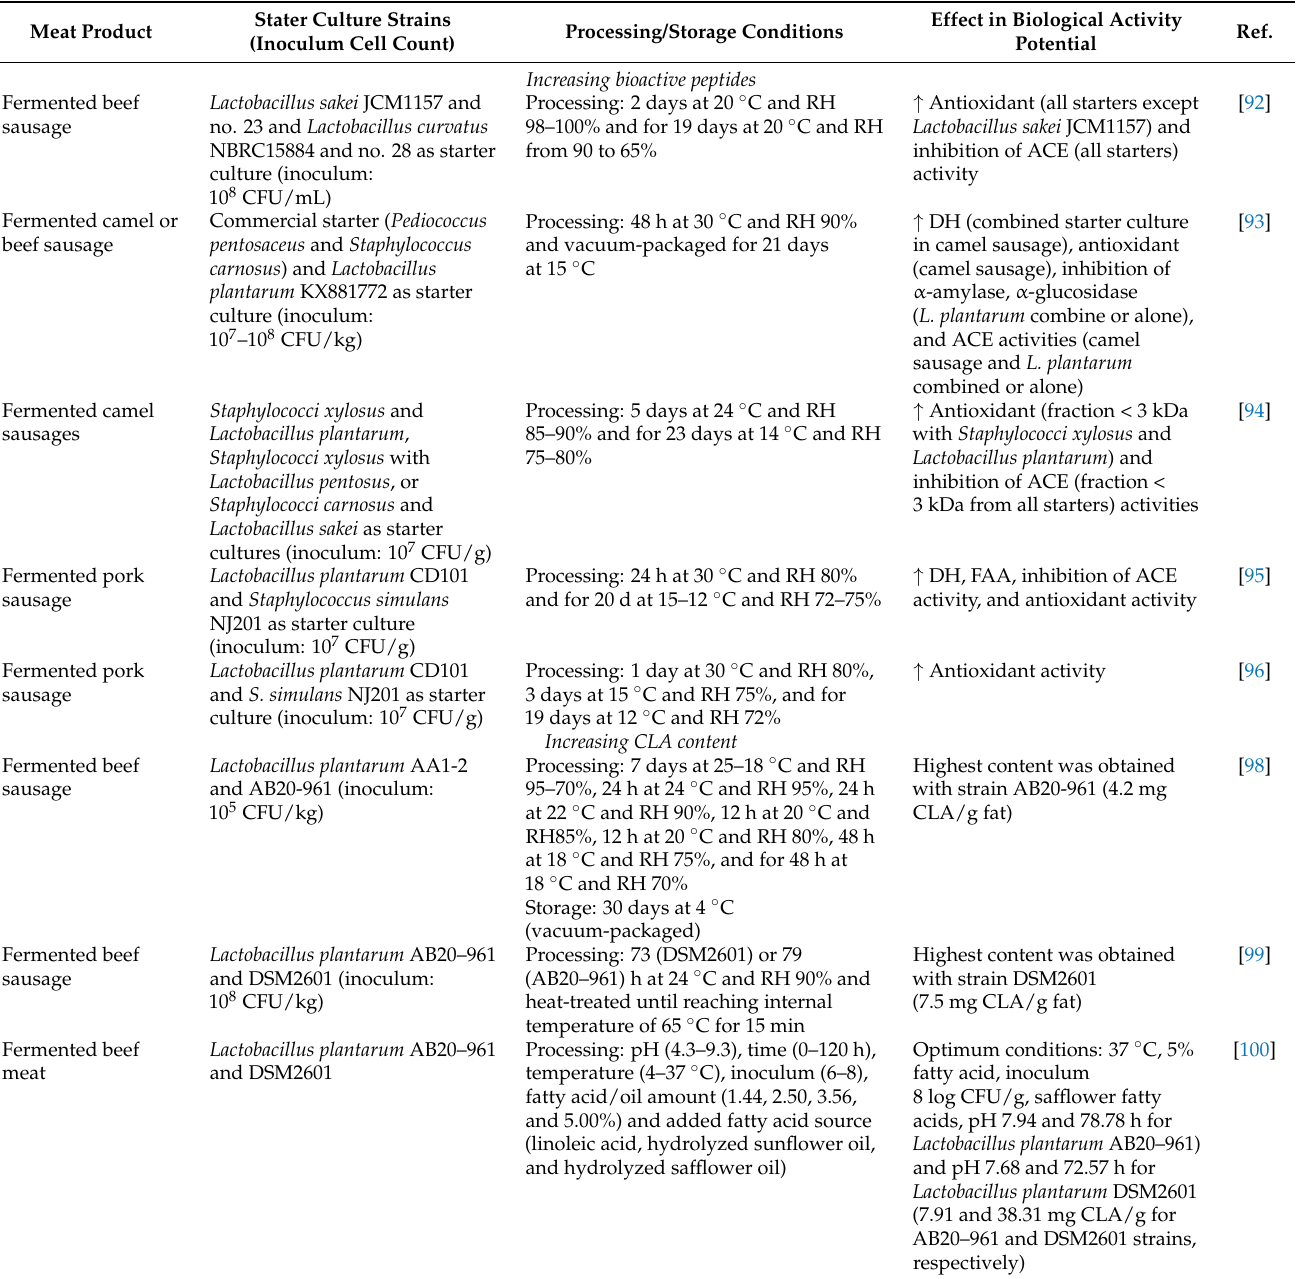
Table 3. Increasing the content of bioactive peptides and conjugated linoleic acid in fermented meat